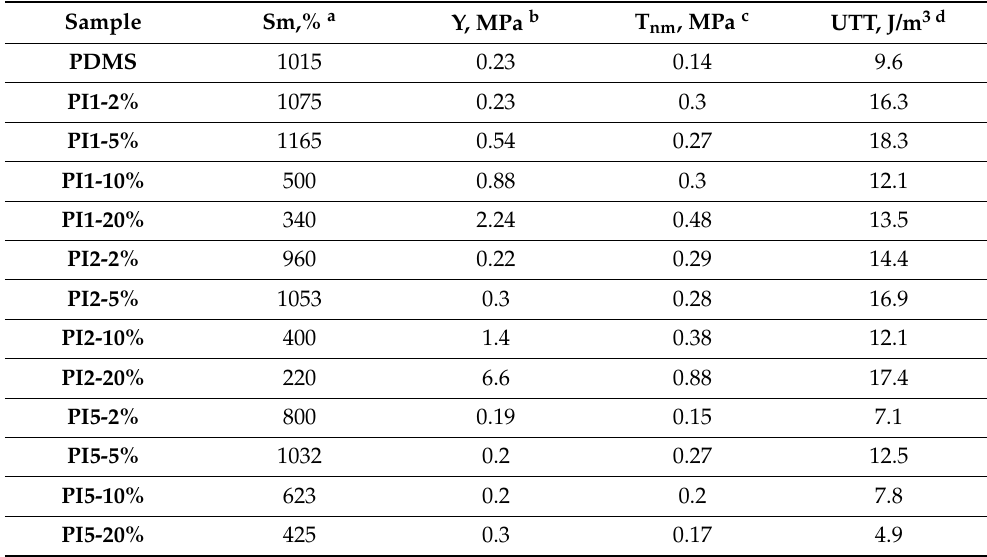
Table 3. Mechanical properties of the series of samples with PI1, PI2, and